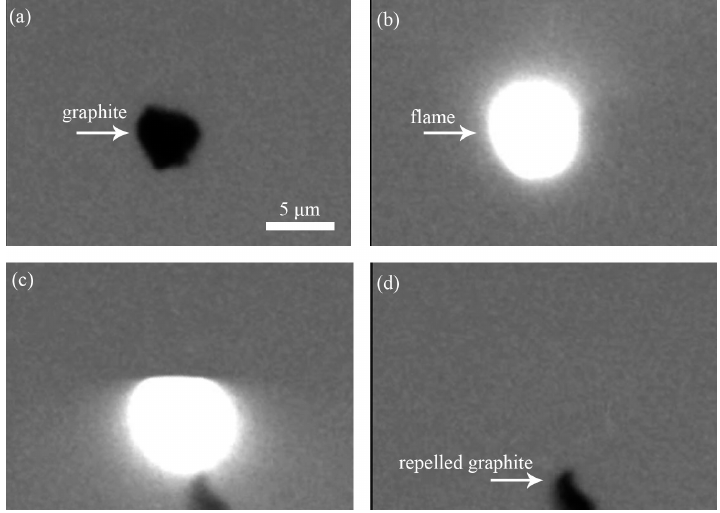
Figure 10. Photophoresis of the graphite particle during combustion, ( a ) 0 ms; ( b ) 6 ms; ( c ) 12 ms; ( d ) 18 ms.